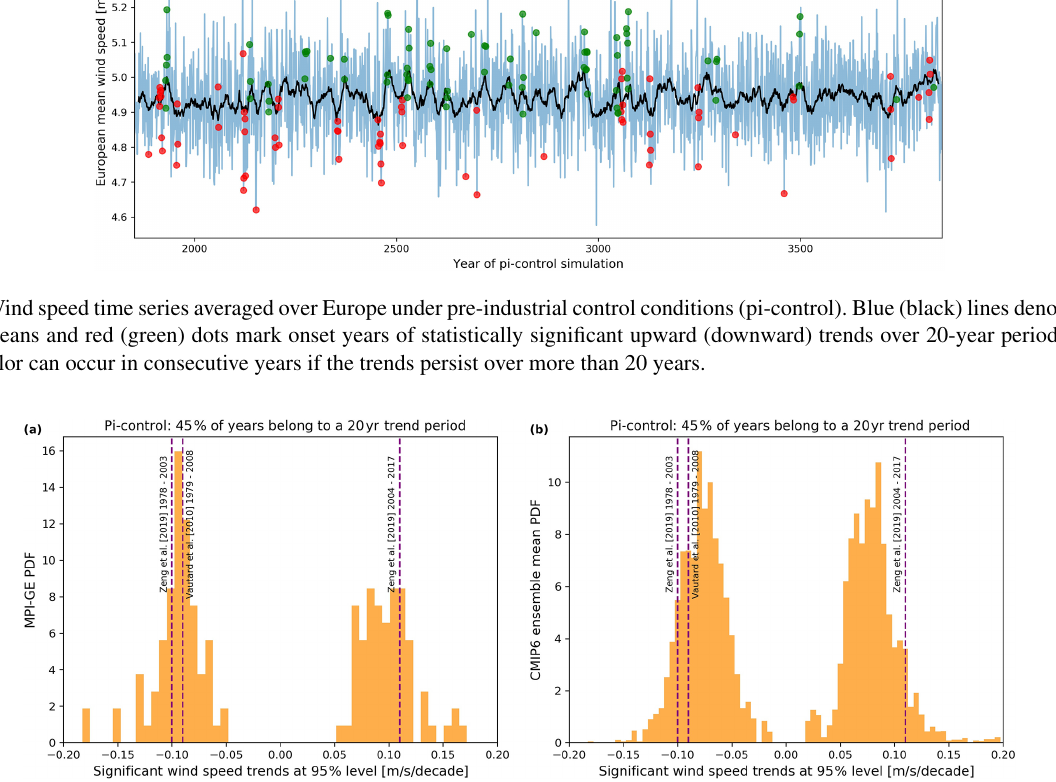
Figure 7. Twenty-year trends in European annual mean wind speed in MPI-GE (a) and the CMIP6 multi-model mean (b) under pre-industrial control conditions (pi-control). Trends are only shown if they are different from zero at a 95% significance level. The CMIP6 histogram is the mean over the trend histograms of the different CMIP6 ensemble members. Two models were excluded from the ensemble mean due to strong model drift (AWI ESM-1-1 LR) and missing data (EC-Earth3-CC); however, there are remaining ensemble members from the two model